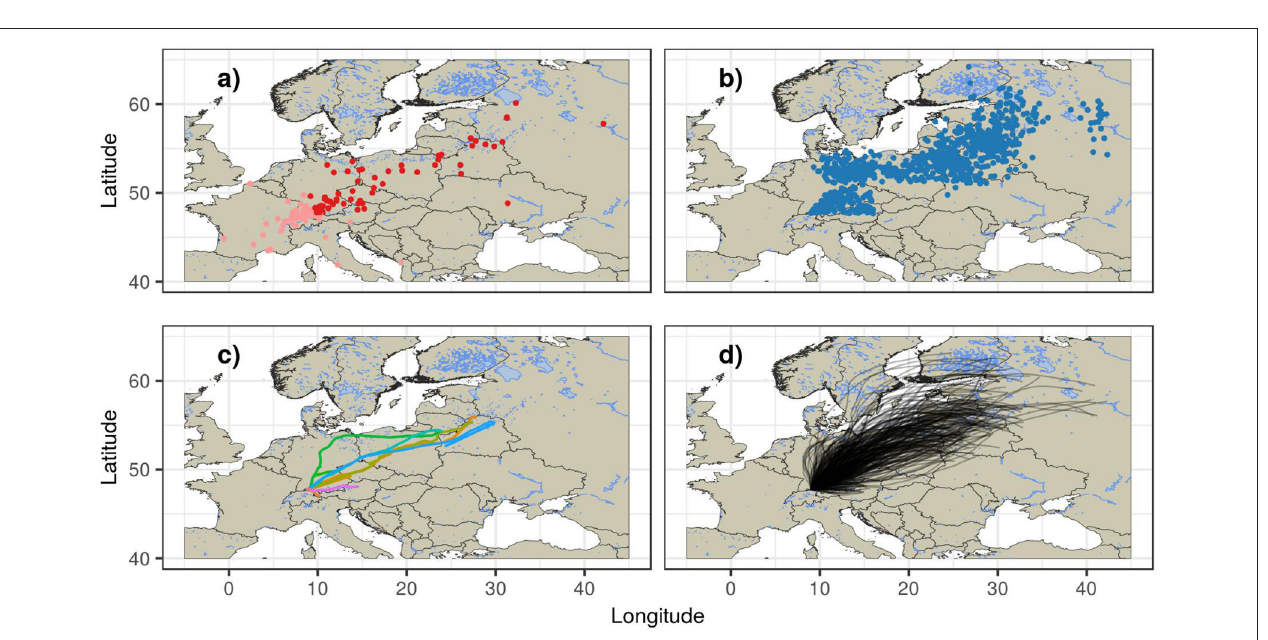
and included missed fixes in the dataset, which occur